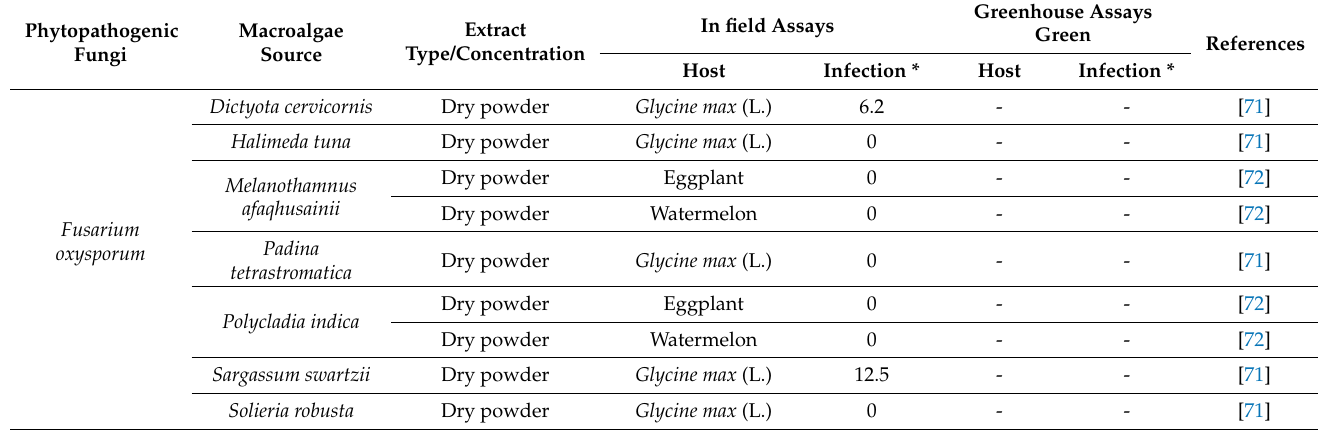
Table 3. Compilation of the best results obtained by macroalgae extracts/dry powder against plants infected with phy- topathogenic fungi using in field methodologies (summary of the information available in Scopus up until 25 February 2021). * Infection expressed in % of infection after application of the macroalgae extract. A: The antimicrobial activity can be due the presence of acrylic acid; B: Increase in effectiveness after a second application; C: Loss of effectiveness for long